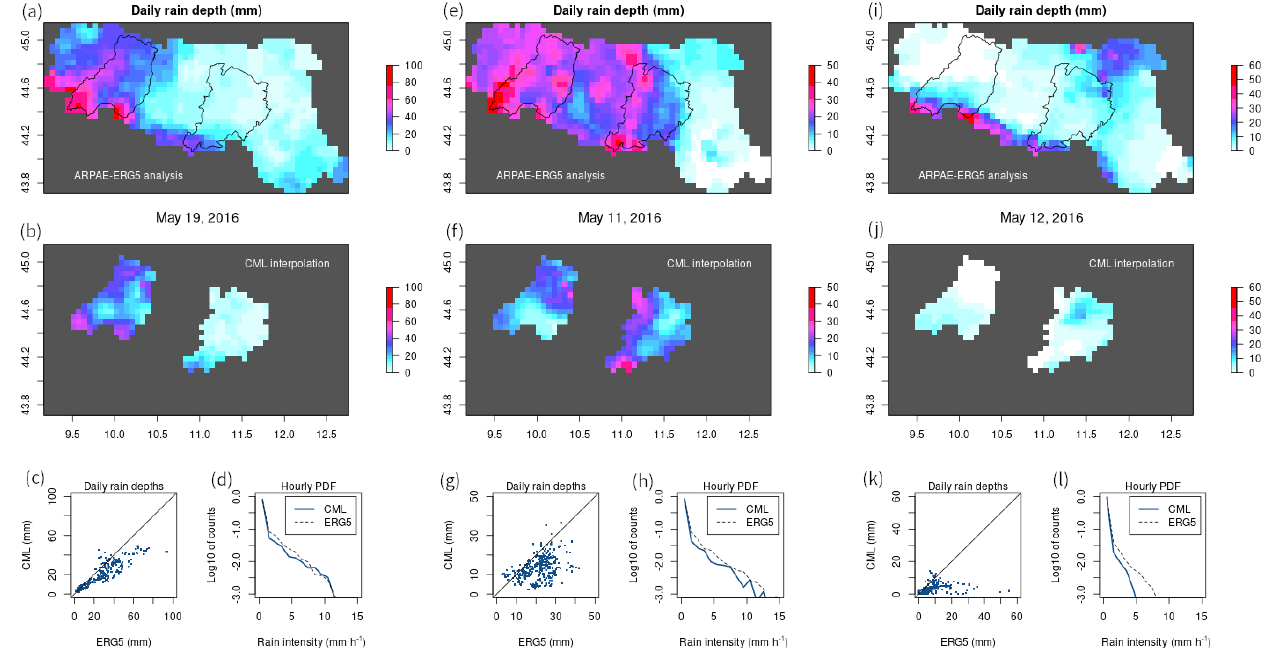
Figure 4. Analysis of three 1d case studies (19 May, a–d ; 11 May, e–h ; 12 May, i–l ): ( a , e , and i ) daily cumulated ERG5 precipitation; ( b , f , and j ) daily cumulated RAINLINK precipitation; ( c , g , and k ) scatter plot between the two daily precipitation values; ( d , h , and l ) PDF of hourly rain rates. Table 2. Comparison with previous studies. Ref is the reference rain rate; Pr is the